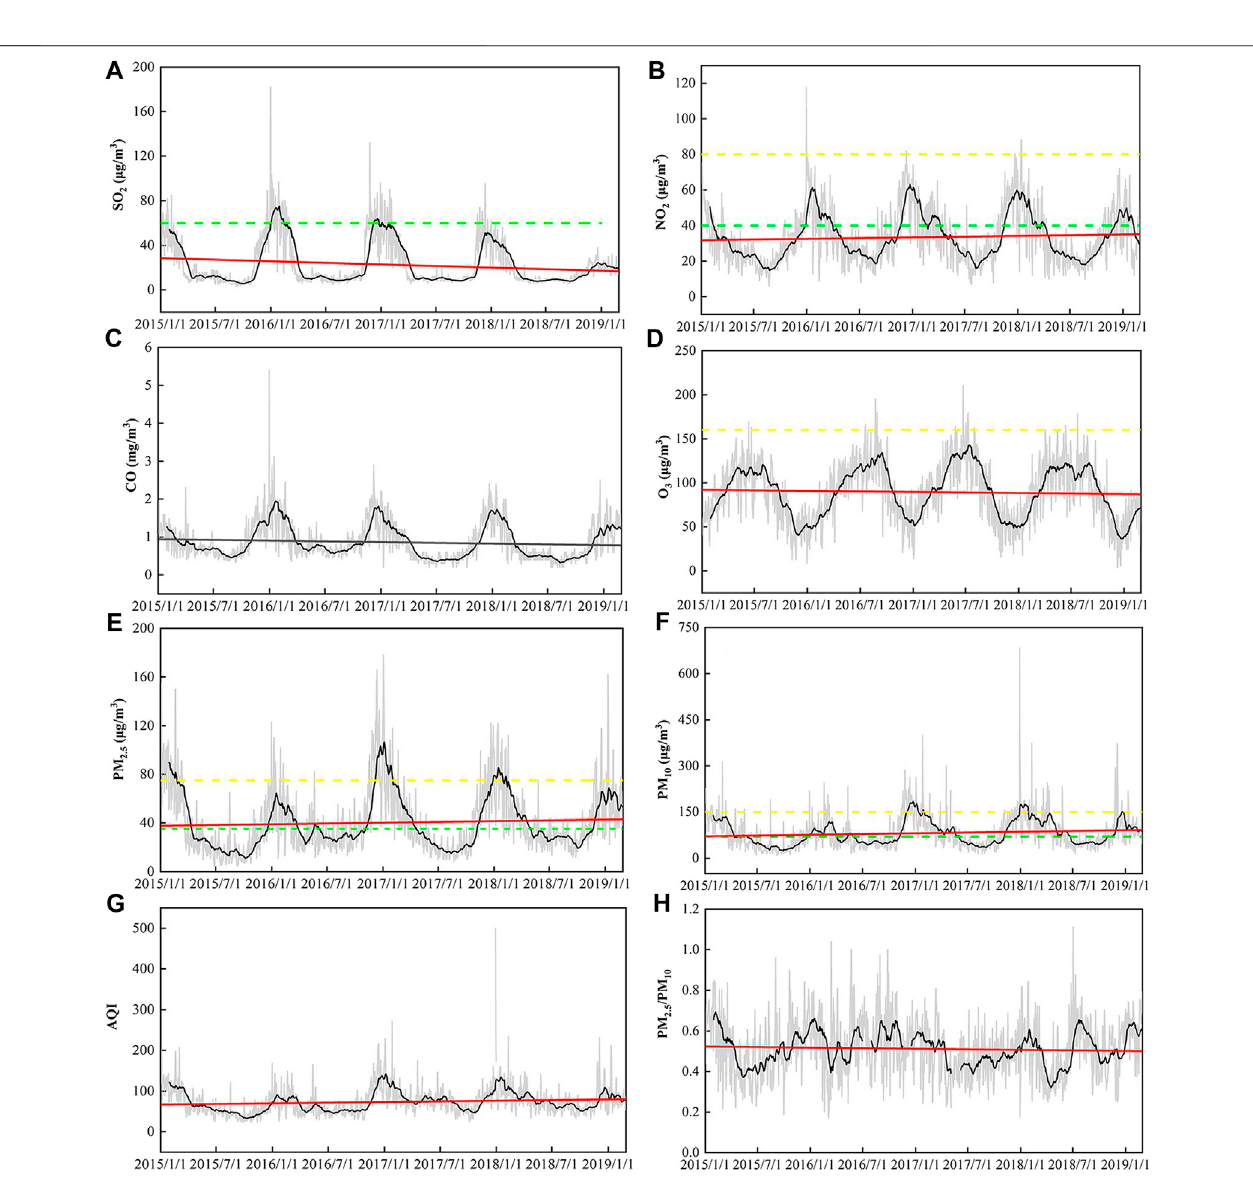
FIGURE 2 | Daily concentrations of pollutants in Tianshui from 2015 to 2018. Black lines are the 30-day moving averages, red lines are the linear trends, green dashed lines are annual mean concentration limit values, and yellow dashed lines are daily mean concentration limit values. (A) SO 2 . (B) NO 2 . (C) CO. (D) 8-hO 3 . (E) PM 2.5 . (F) PM 10 . (G) AQI. (H) PM 2.5 /PM 10.